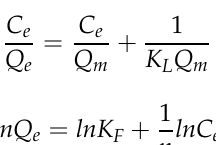
Figure 3. The mechanism of suspension grafting polymerization of AA and MAH monomers. 3.2. Effect of Quenching Treatment The PP used in this research is a special raw material for melt-blown process. It has high crystallinity, but the suspension grafting modification is mainly carried out in the amorphous regions of PP. Therefore, the PP melt can be quenched to reduce its crystallinity, which makes the grafting polymerization easier. It can be seen from the X-ray diffraction patterns of PP before and after the quenching treatment in Figure 4 that the dispersion peak intensity (shaded area in the figure) of the amorphous region of the quenched PP was significantly greater than that of the original PP. Since the quenching process greatly shortens the crystallization time of the PP melt, some of the PP macromolecular chains have no time to move, transform from the disordered coils and then grow into crystals, which results in lower crystallinity.